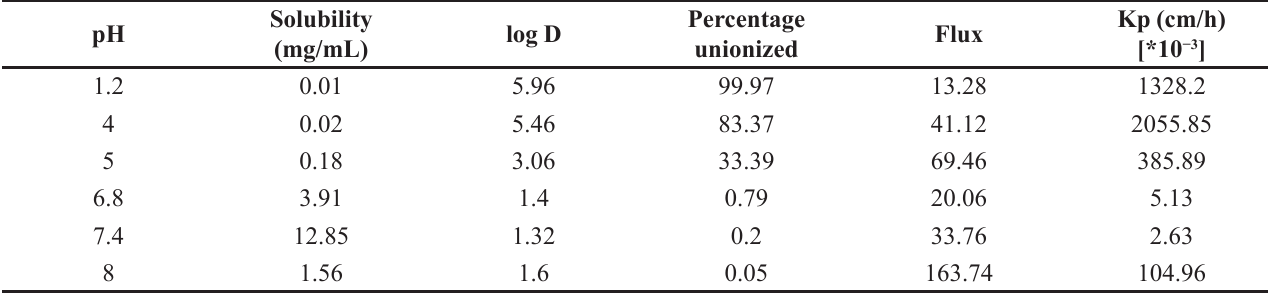
TABLE II - Solubility, distribution coefficient, % of unionized drug and skin permeability parameters of Aceclofenac pH